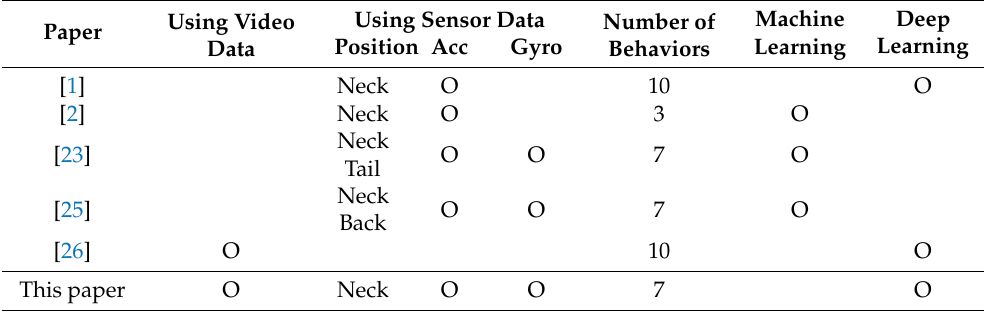
Table 1. Summary of dog behavior recognition studies using a camera or wearable